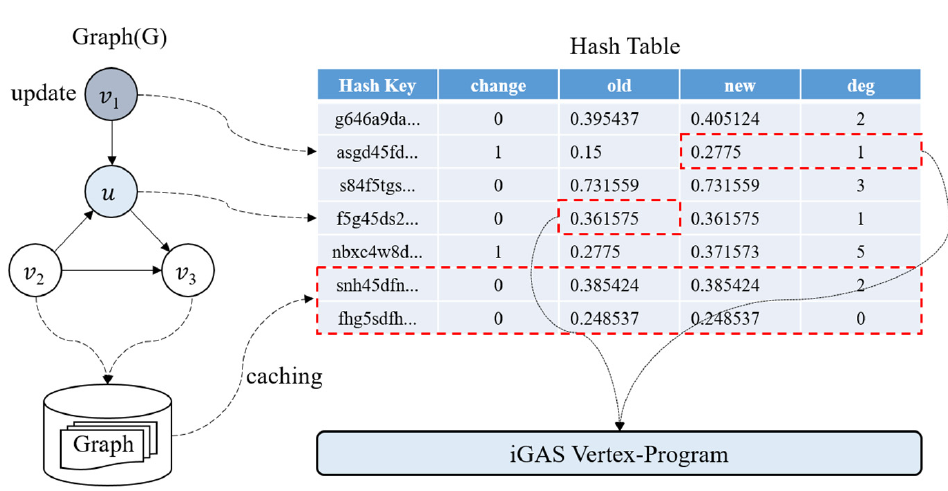
Figure 6. Cache management.